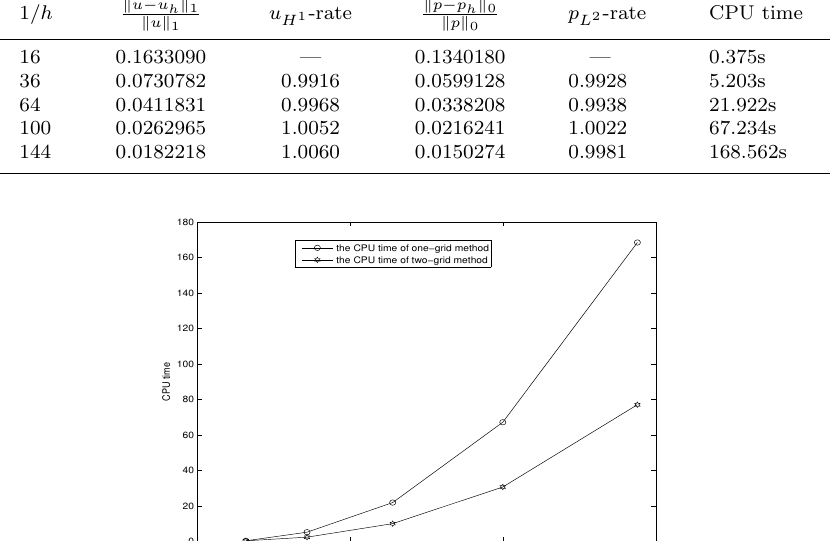
Table 8. Relative error and convergence rate of the one-grid method for the velocity and flux with τ 2 = h and ν = 1. 1 /h